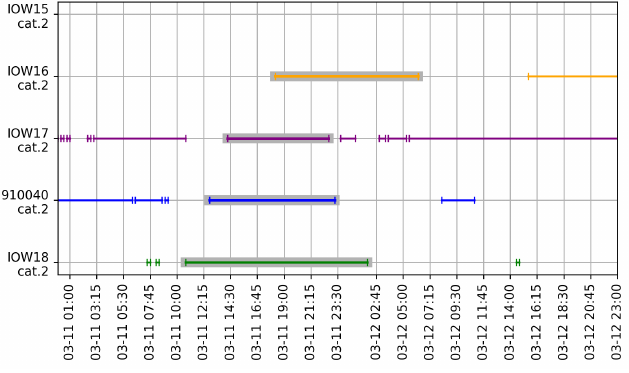
Figure 24 shows the resulting intervals shaded in grey over the lines representing the values of the categories (again,the value is 2 for all stations) for each station at different intervals. We can see that choosing a different time window yields longer intervals than with the longer window in Query 4.